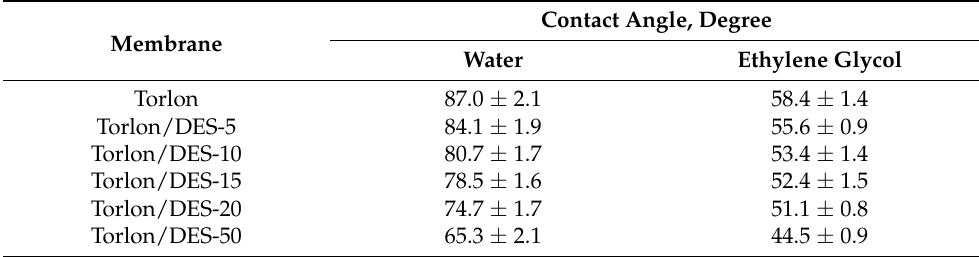
Table 1. Contact angles of Torlon/DES composites.